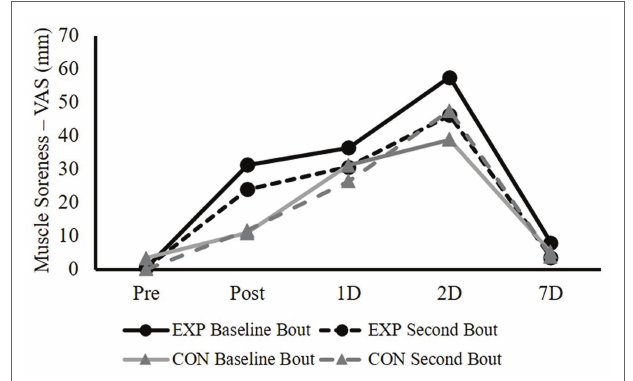
FIGURE 3 | The responses of knee flexor (KF) muscle soreness (measured by VAS) immediately after (Post), 1 day after (1D), 2 days after (2D), and 7 days after (7D) the baseline and the second bouts of ECC for both experimental (EXP) and control (CON) groups.